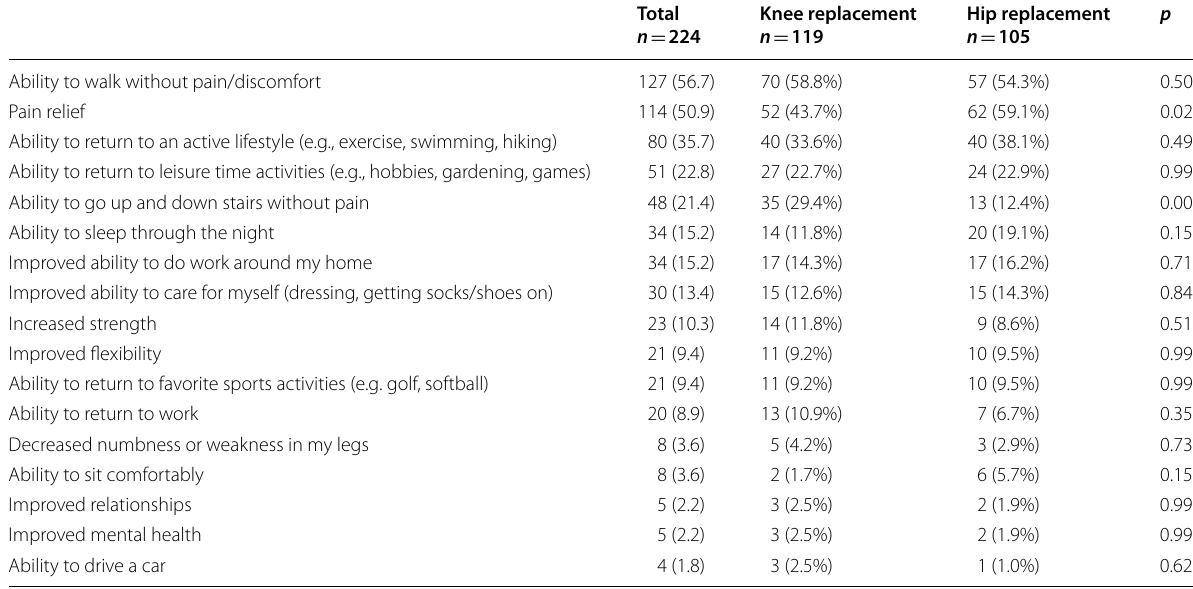
Table 2 Most important personalized outcomes for surgery in frequency order